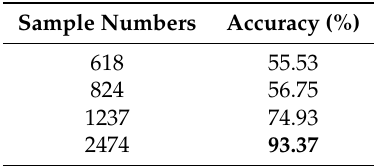
Table 6. Classification accuracies (%) under different number of cloud samples in the training